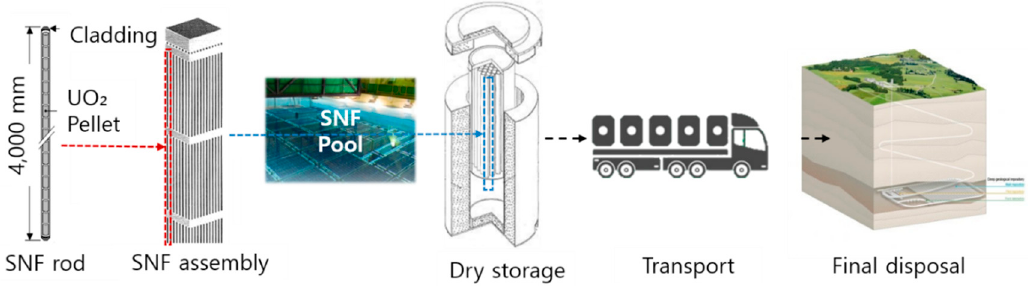
Figure 1. Management of SNF in the open fuel cycle [1].